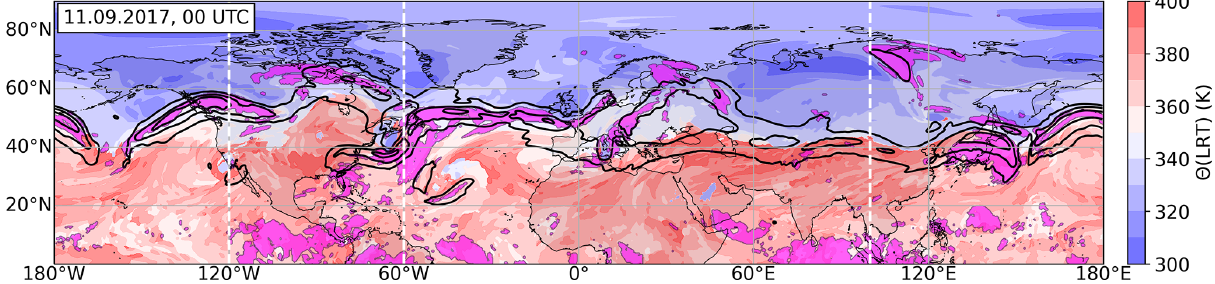
Figure 2. Potential temperature at the LRT ( (cid:50)( LRT ) , in K) over the Northern Hemisphere on 11 September 2017 at 00:00UTC. Black lines show contours of the horizontal wind at 200hPa, beginning at 30ms − 1 in steps of 15ms − 1 . Magenta-shaded areas indicate regions S 2 ≥ S 2 t between 1km below and 2km above the local LRT. Dashed white lines indicate the location of the vertical cross sections in Fig.